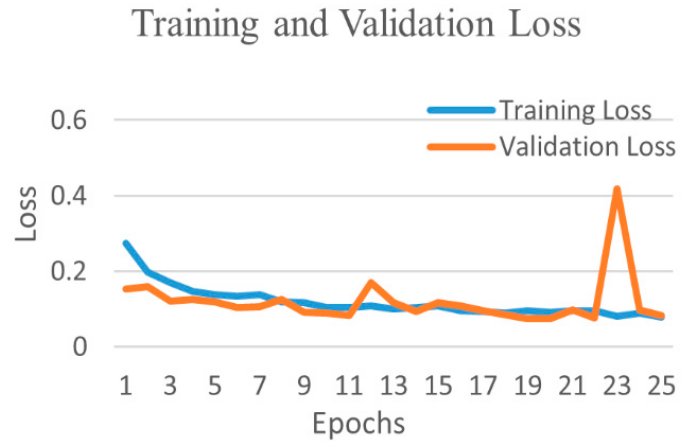
Figure 5. Training and validation loss of best performing VGG16 network for COVID-19 and normal class.